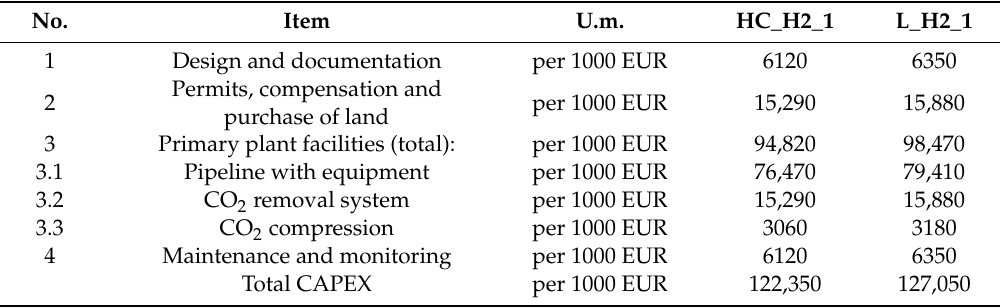
Table 2. The structure of CAPEX for CCS.